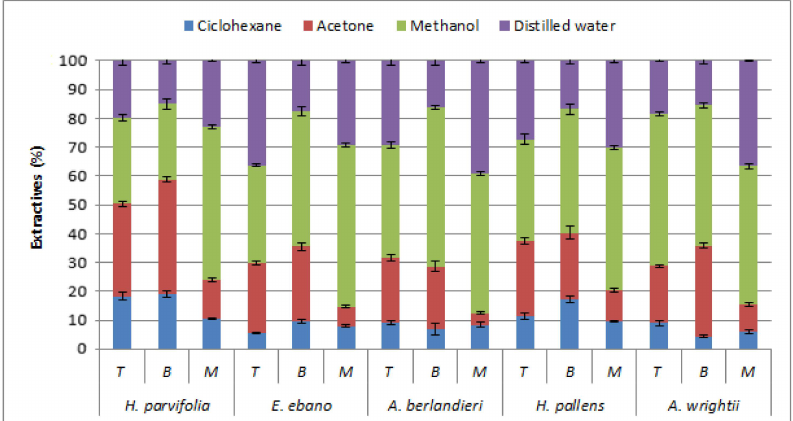
Figure 3. Amounts of extractives from five timber species of the semi-arid land of Mexico, in different biomass components (T = trunk, B = branches and M = twigs) with different